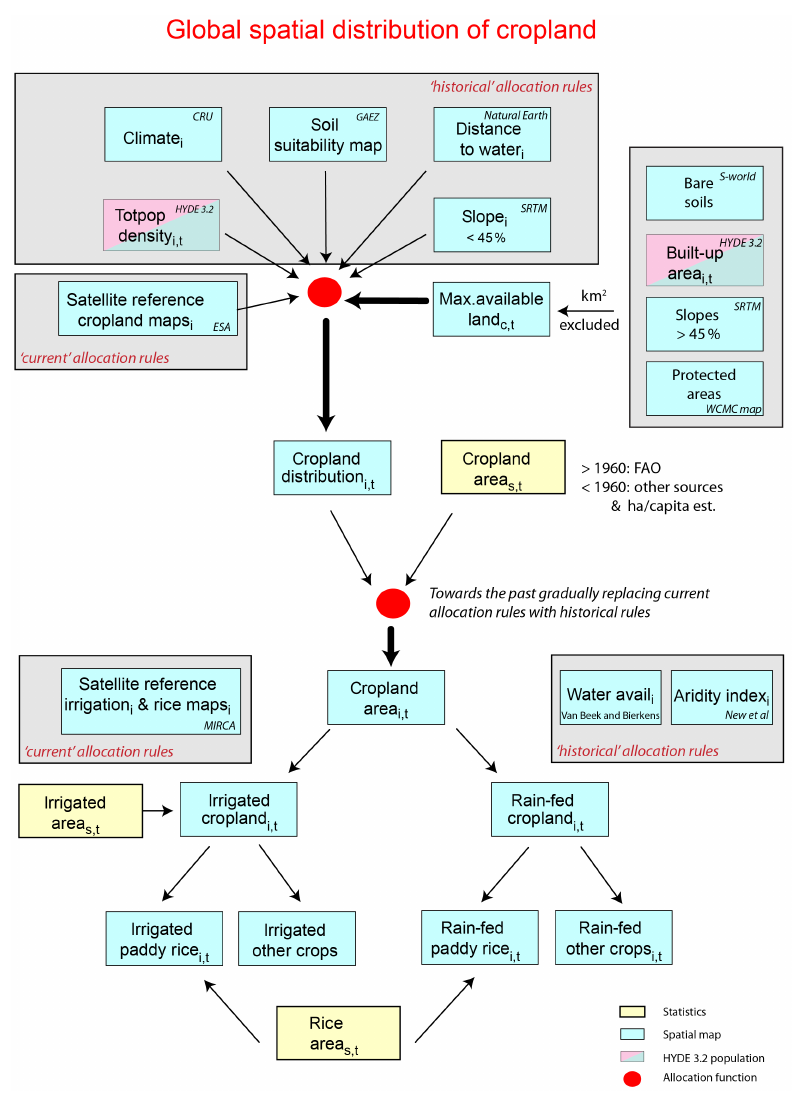
Figure 2. Cropland allocation scheme.